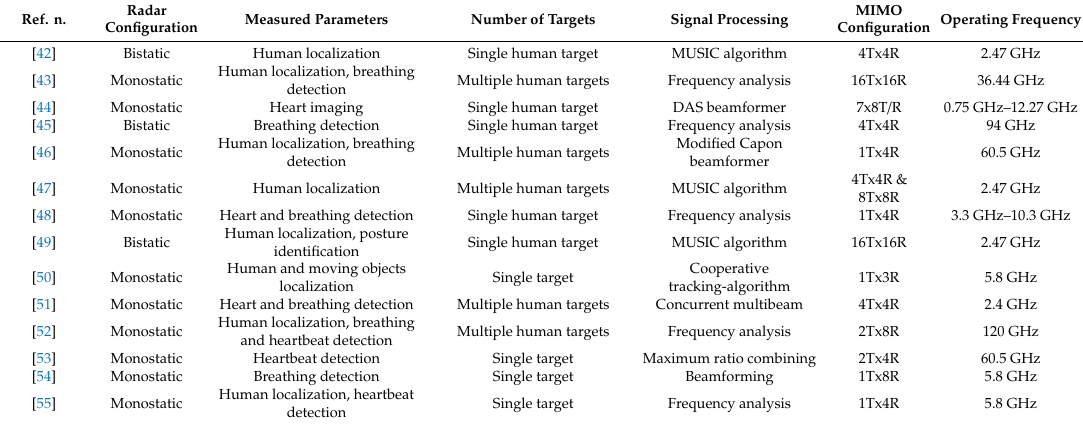
Table 1. Main properties of the reported biomedical MIMO